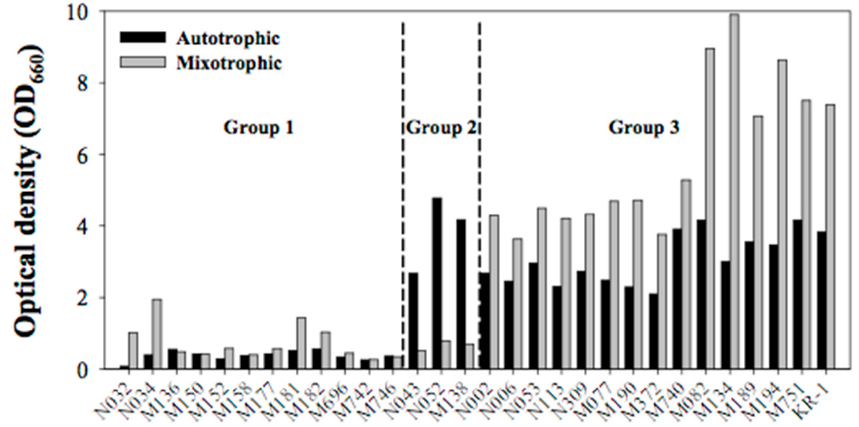
Figure 1. Growth of Chlorella spp. (30 strains) under autotrophic and mixotrophic conditions. The optical density was measured at 660 nm at the end of 50 h cultivation in b-PBRs. The mixotrophic cultures were supplemented with 5 g glucose/L.